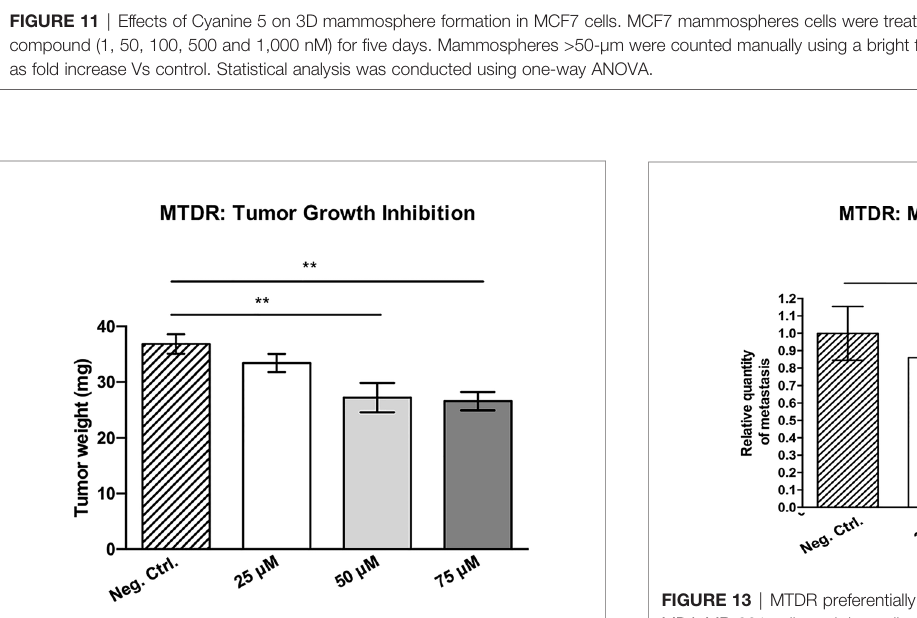
FIGURE 12 | MTDR signi fi cantly inhibits tumor growth. MDA-MB-231 cells and the well-established chorio-allantoic membrane (CAM) assay in chicken eggs were used to quantitatively measure tumor growth. See Materials & Methods for speci fi c details. After 8 days of MTDR administration, on day E18 all tumors were weighed. Note that MTDR signi fi cantly inhibited tumor growth, by up to nearly 30%, at a concentration of 75 m M (n ≥ 15). Averages are shown ± SEM. **p < 0.01; *p < 0.05. Statistical analysis was conducted using ANOVA.